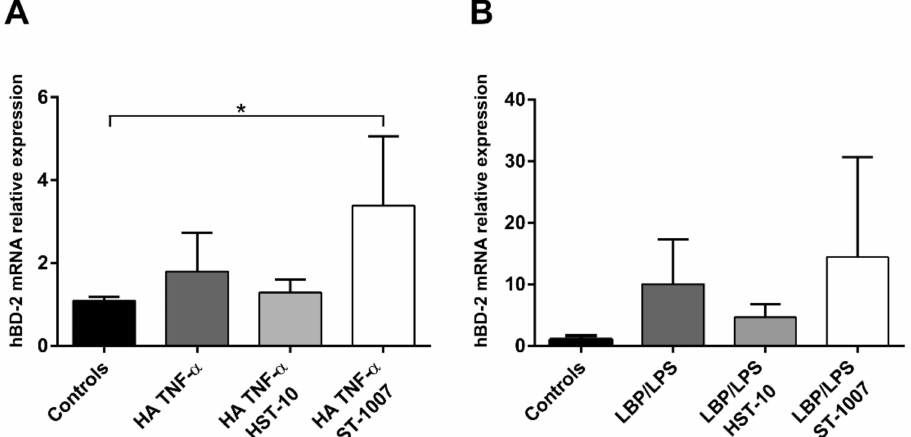
Figure 5. ( A ) Activation of H4R with its agonist HST-10 slightly decreased hBD-2 expression induced by histamine (HA) and TNF- α as compared with the controls (8 h), while this effect was reversed by the inverse agonist ST-1007. ( B ) In a similar trend, ST-1007 induced hBD-2 expression in HOKs via a lipopolysaccharide-binding protein (LBP)/LPS-mediated pathway (24 h), whereas HST-10 diminished such an effect. Data are expressed as means ± SD; * p ≤ 0.05. Kruskal–Wallis test followed by